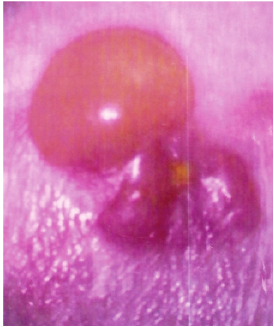
Figure 1 - Vesicular lesion with almost 3 or 4 cm and blister aspect.